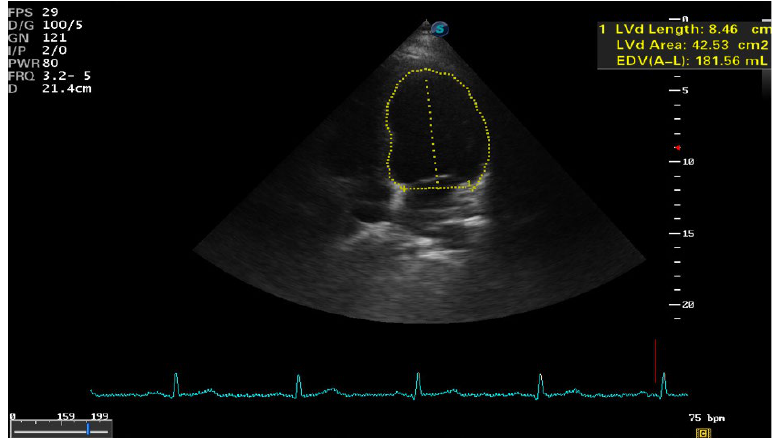
Figure 10. Case 3—TTE Left ventricle tele-diastolic volume evaluation (yellow dotted line).